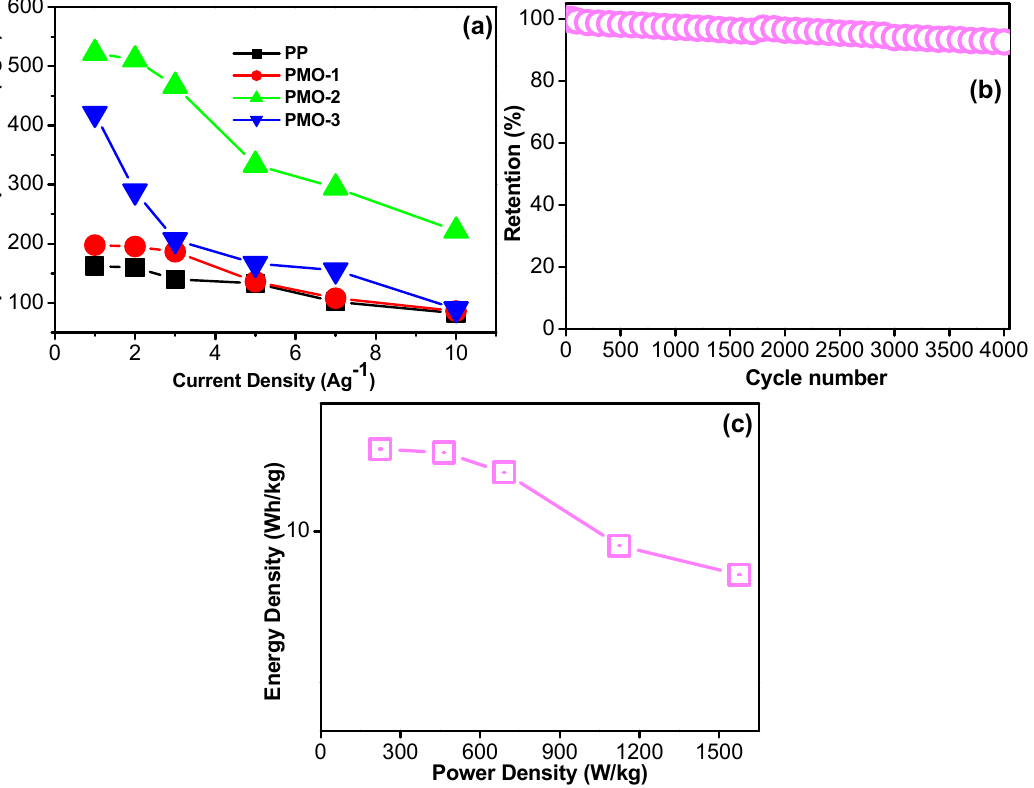
Figure 6. ( a ) Specific capacitance graph of PP, PMO-1, PMO-2, and PMO-3 recorded at a current density of 1–10 A/g; ( b ) cyclic stability graph of the PMO-2 electrode; and ( c ) power and energy density spectra of the PMO-2 electrode. Table 2. Comparison of the performance of the present electrode with previous published